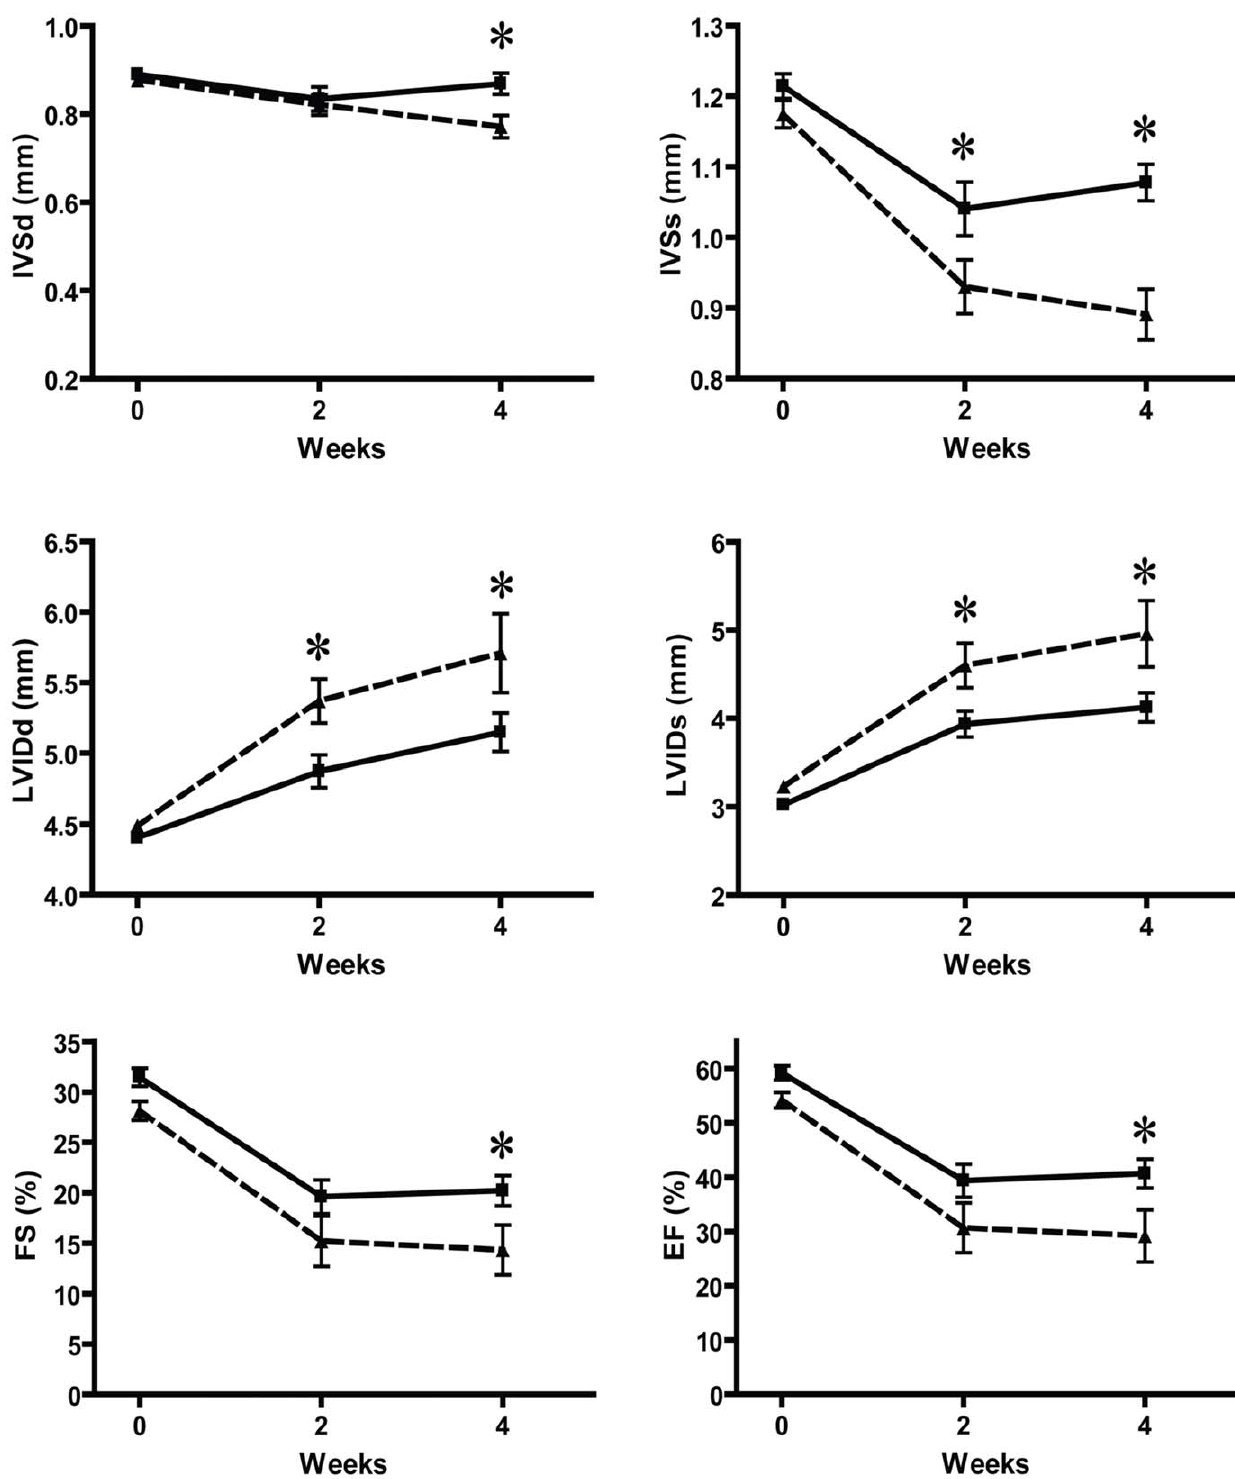
Figure 2. Transthoracic echocardiography of NLC and Tg-CTGF mice at successive time points after MI. Successive echocardiographic recordings of inter-ventricular septum thickness (IVS) and LV transverse diameter (LVID) at end-diastole and end-systole, as well as fractional shortening (FS) and estimated ejection fraction (EF) in the total number of NLC CHF ( m ) and Tg-CTGF CHF mice ( & ), at baseline and 2 and 4 weeks after ligation of LAD. Values are mean 6 SEM of NLC CHF and Tg-CTGF CHF mice. * P , 0.05 vs. NLC group.